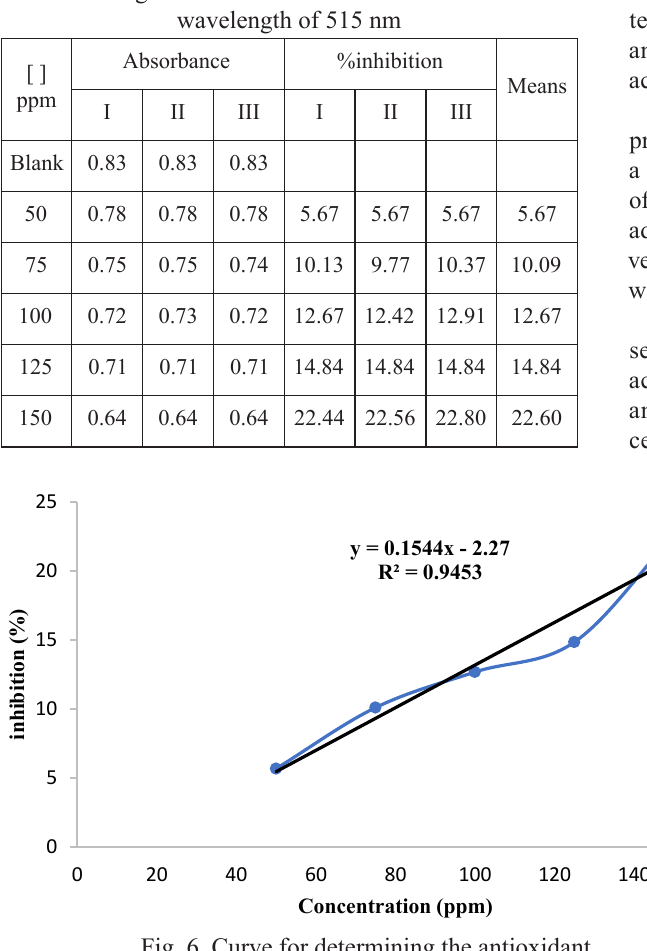
Fig. 6. Curve for determining the antioxidant activity of